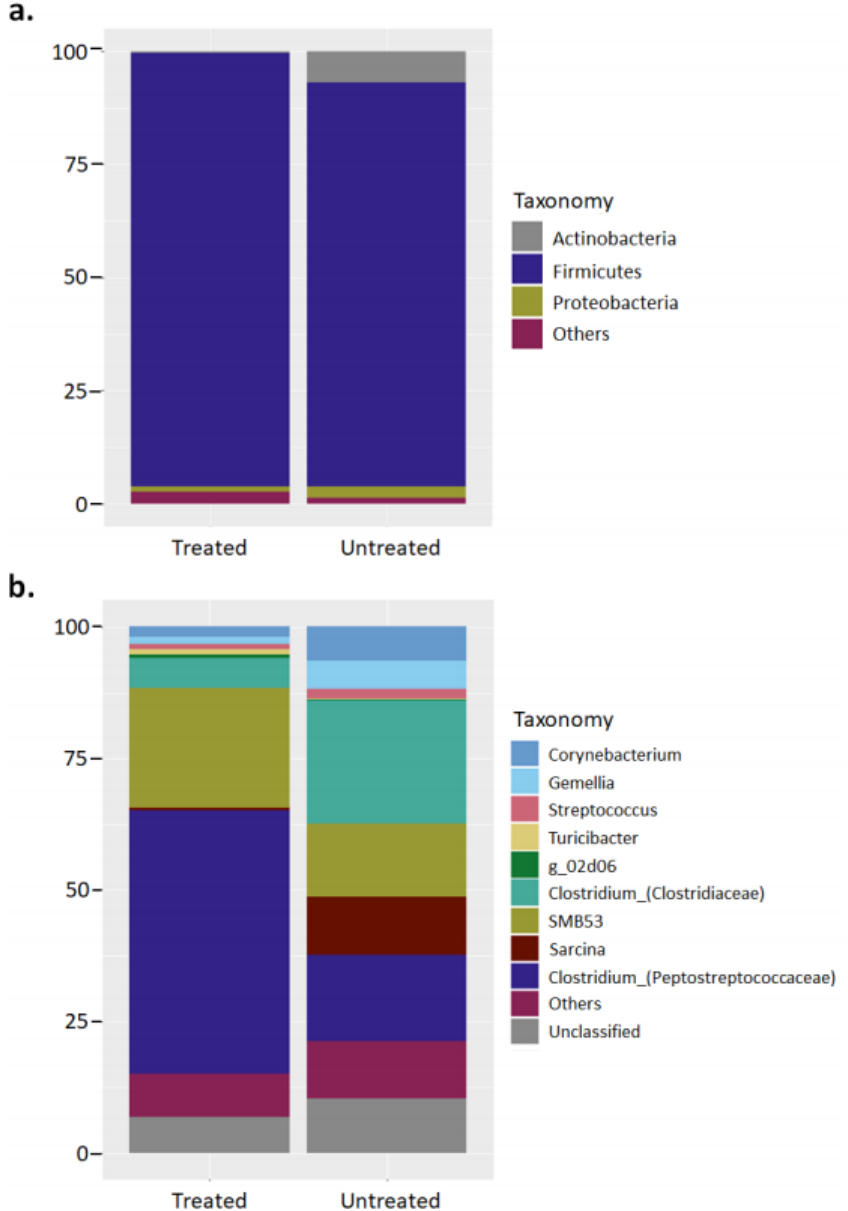
Figure 2. Major bacterial phyla and genus in the proximal and distal small intestine of captive hooded seals depending on whether they received antibiotic treatment or not. The bar charts represent the relative abundance of the total 16S rRNA sequence taxonomically classified at ( a ) phylum and ( b ) genus level. Classification was performed with partial sequences of the bacterial 16S rRNA gene against the RDP-II database using RDP classifier